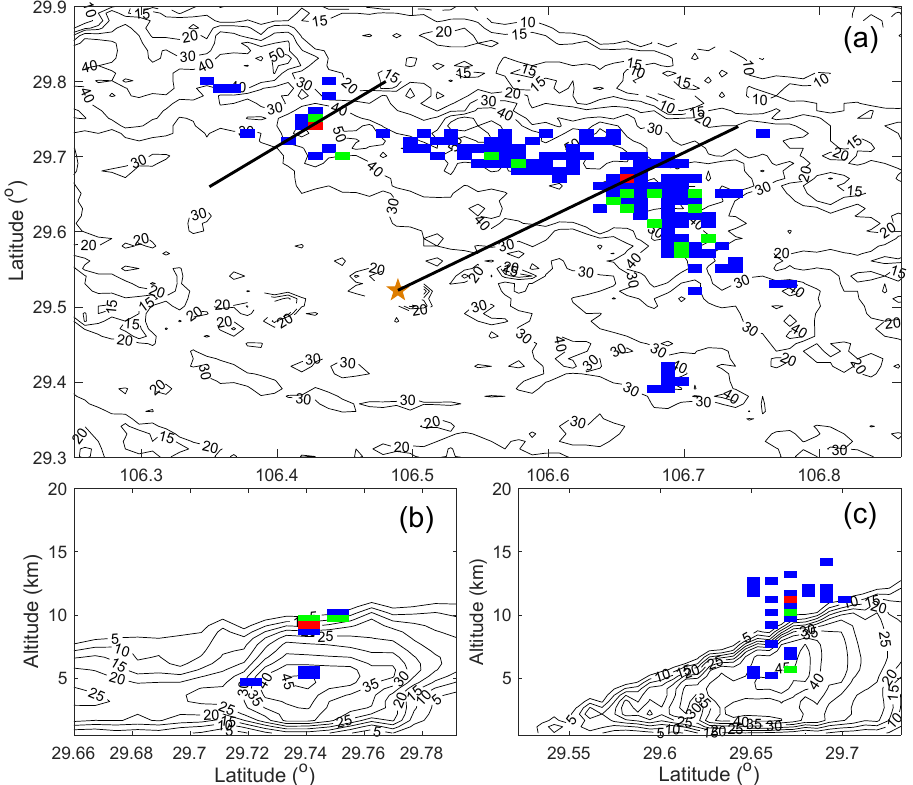
29.66 29.68 29.7 29.72 29.74 29.76 29.78 Latitude ( o ) Figure 5. Distributions of the reflectivity and the LD, HD, and SD grids in ( a ) the horizontal and ( b , c ) the vertical planes at 17:39 CST. The contours in ( a – c ) indicate the distribution of ( a ) composite reflectivity in the horizontal and ( b , c ) reflectivity in the vertical (unit: dBZ). The blue, green, and red rectangles represent the LD, HD, and SD grids, respectively. The yellow star in ( a ) shows the location of the radar site. The black lines in ( a ) illustrate the positions of the vertical sections in ( b , c ), respectively. One of the SD grids shown in the left-hand cell of Figure 5a,b was located at 9.2 km, and had an initiation density of four flashes grid − 1 6 min − 1 . Another SD grid in the right- hand cell appeared at 11.2 km with an initiation density of three flashes grid − 1 6 min − 1 . The channels of the flashes initiated in the SD grid on the left, which had a higher initiation density, are illustrated in Figure 6. Regrettably, due to the limitation of the maximum elevation of the radar beam, the reflectivity in many parts of these lightning channels was missed. The maximum and minimum differences between the initiation times of the four flashes were ~36.883 and ~20.291 s, respectively, with a mean value of ~30.44 s. The maximum differences in longitude and latitude of their initiation positions were 0.003 ◦ and 0.002 ◦ , respectively. According to the distribution of the channels (Figure 6), it is obvious that these lightning channels (dominated by negative leaders) did not follow the same